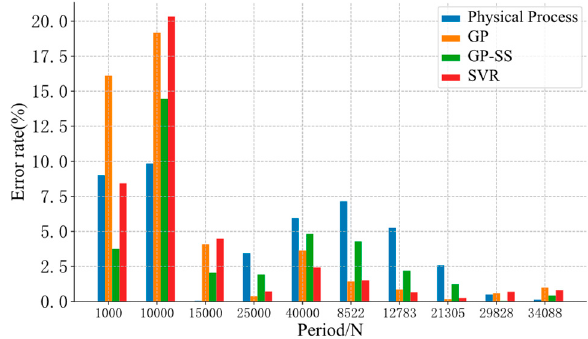
Figure 10. The error rate of different models.